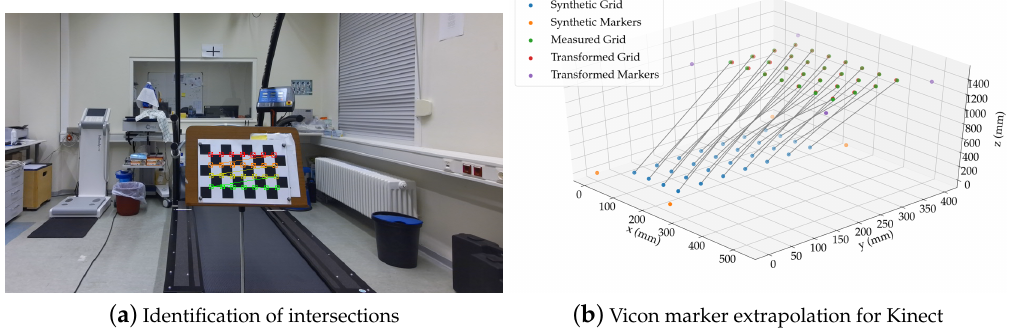
Figure 5. Camera calibration using four retro-reflective 14 mm markers on the corners of the